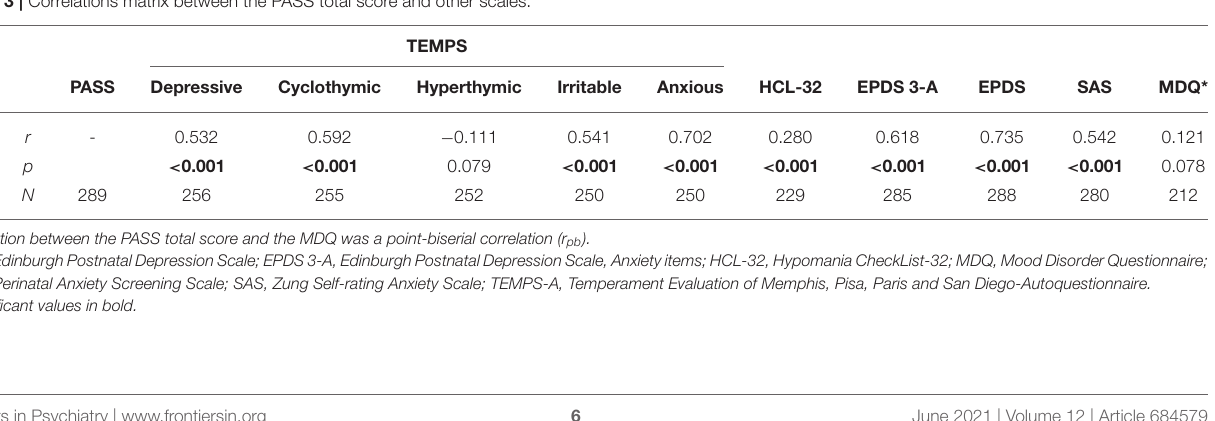
TABLE 3 | Correlations matrix between the PASS total score and other